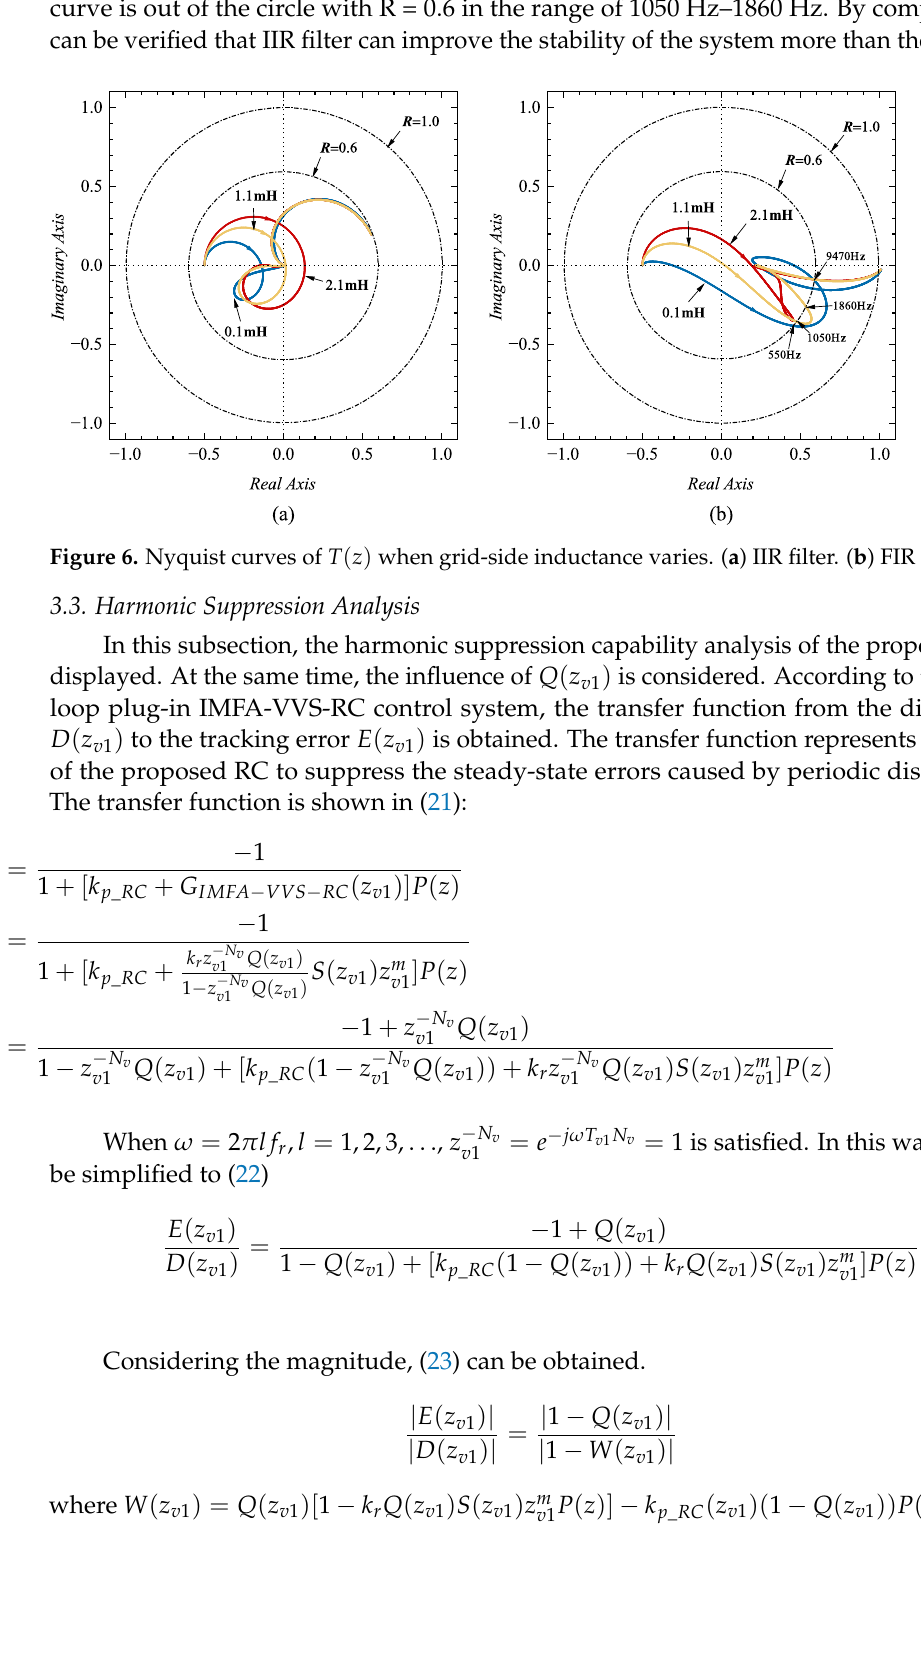
Figure 6a,b, the IIR filter can restrict the Nyquist curves to a circle with R = 0.6, so the stability margin can be defined as 1/ R = 1.67. When a FIR filter is used, there is no guarantee that the Nyquist curves are always inside the circle with R = 0.6. Through specific quantitative analysis, when the inductance is 0.1 mH, the curve is out of the circle with R = 0.6 in the range of 550 Hz–9470 Hz, while when the inductance is 1.1 mH, the curve is out of the circle with R = 0.6 in the range of 1050 Hz–1860 Hz. By comparison, it can be verified that IIR filter can improve the stability of the system more than the FIR filter.